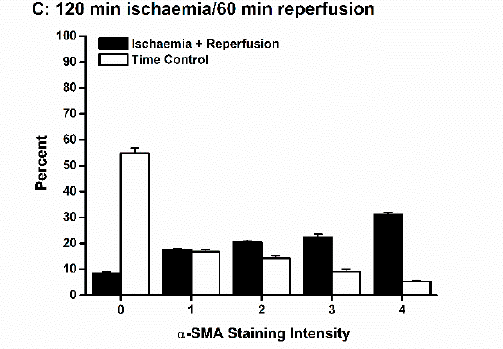
Figure 8. Ischemia reperfusion ( IR) injury was associated with differentiation of fibroblasts into both immature and mature myofibroblasts. Each of the three durations of ischemia, 30 min ( A ), 60 min ( B ) and 120 min ( C ), yielded both immature ( α smooth muscle actin ( α -SMA) staining intensities 1–3) and mature ( α -SMA staining intensity 4) myofibroblasts. In contrast, in each time control (TC), there were